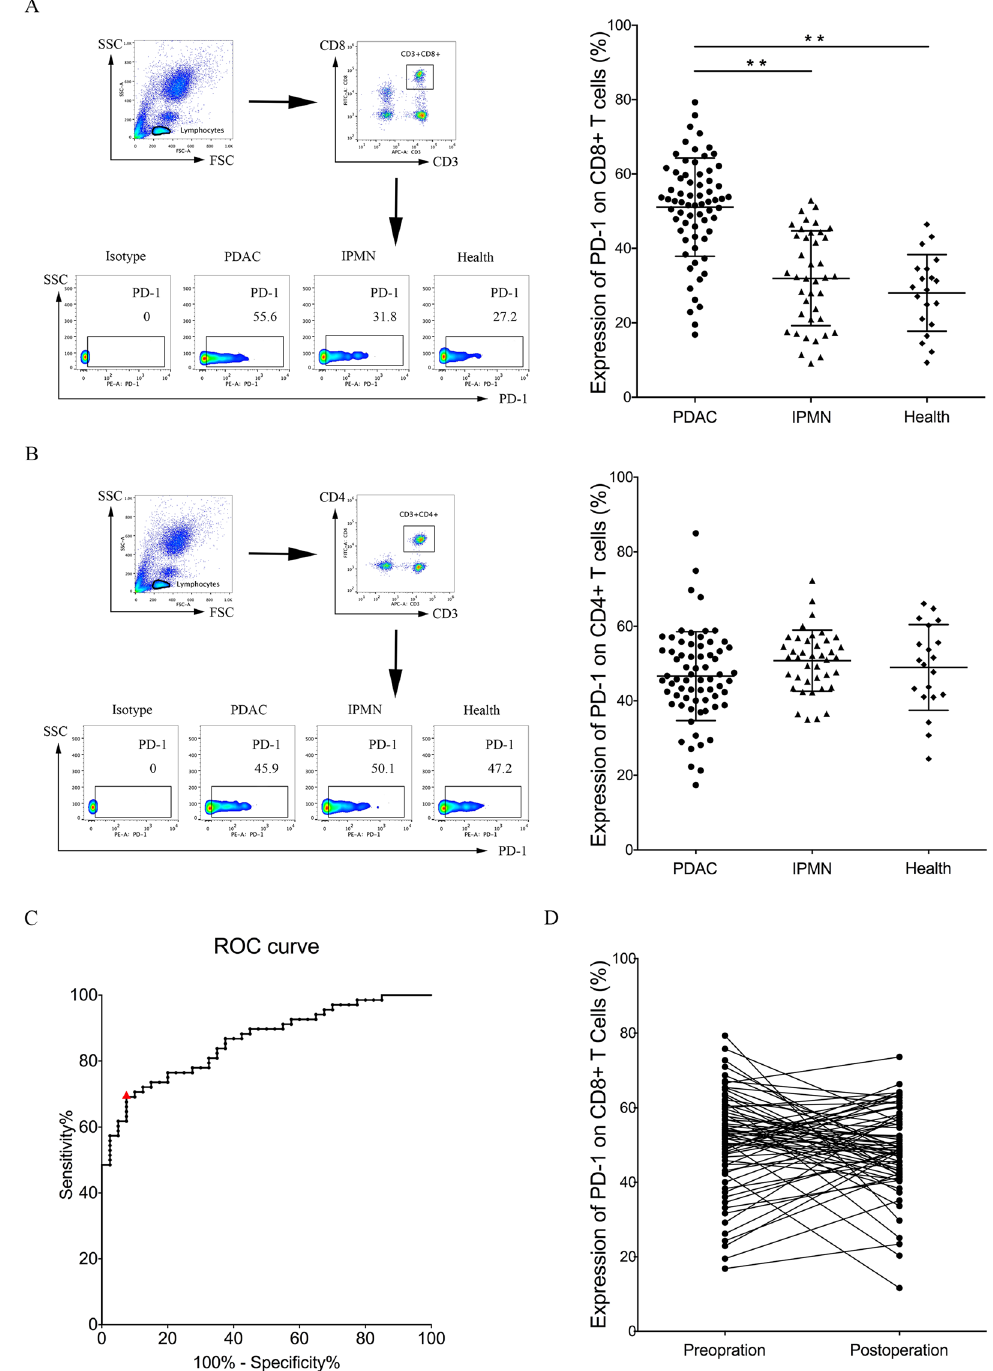
Figure 2. PD-1 protein expression is increased on peripheral CD8 + T cells but not on peripheral CD4 + T cells in patients with pancreatic ductal adenocarcinoma. The levels of PD-1 protein expressed by peripheral CD8 + T lymphocytes ( A ) and peripheral CD4 + T lymphocytes ( B ) in 68 patients with PDAC, 40 patients with intraductal papillary mucinous neoplasm (IPMN), and 20 healthy donors were detected by flow cytometry. Graphs show quantification of FACS data. Flow cytometry pseudo colour of lymphocytes and CD3 + CD8 + (A) or CD3 + CD4 + ( B ) cells and representative smoothing pseudo colour of PD-1 + cells are displayed. Data shown are mean ± standard deviation, ** P < 0.001. ( C ) ROC curve for the correlation of PD-1 expression on peripheral CD8 + T cells with PDAC. Area under the curve is 0.8607 (95% confidence interval 0.7938 to 0.9276), P < 0.001. The cut-off value of > 47.81% PD-1 expression on CD8 + T cells is designated by the red triangle. ( D ) There was no significant difference in the level of PD-1 expression between preoperative and 4-week postoperative peripheral CD8 + T lymphocytes. Wilcoxon matched-pairs signed rank test; P =